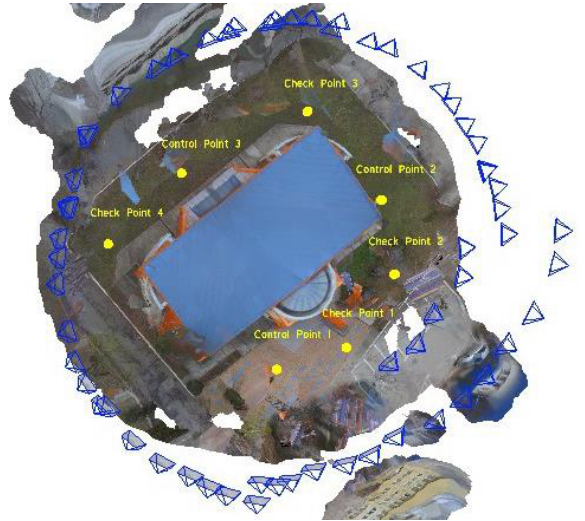
Figure 4. The visualization of the Control Points 1, 2 and 3, the Artificial Check points 1, 2, 3 and 4 and the camera positions